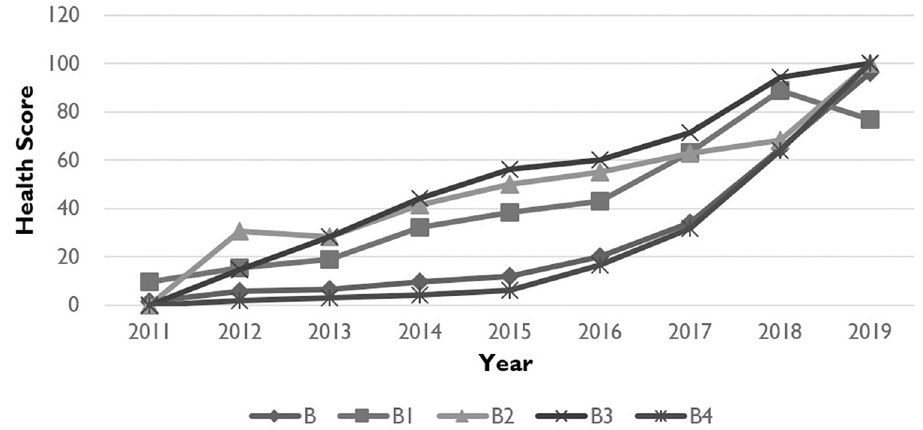
Fig 3. Health of innovative environment in pharmaceutical innovative ecological rainforest in Zhejiang Province: